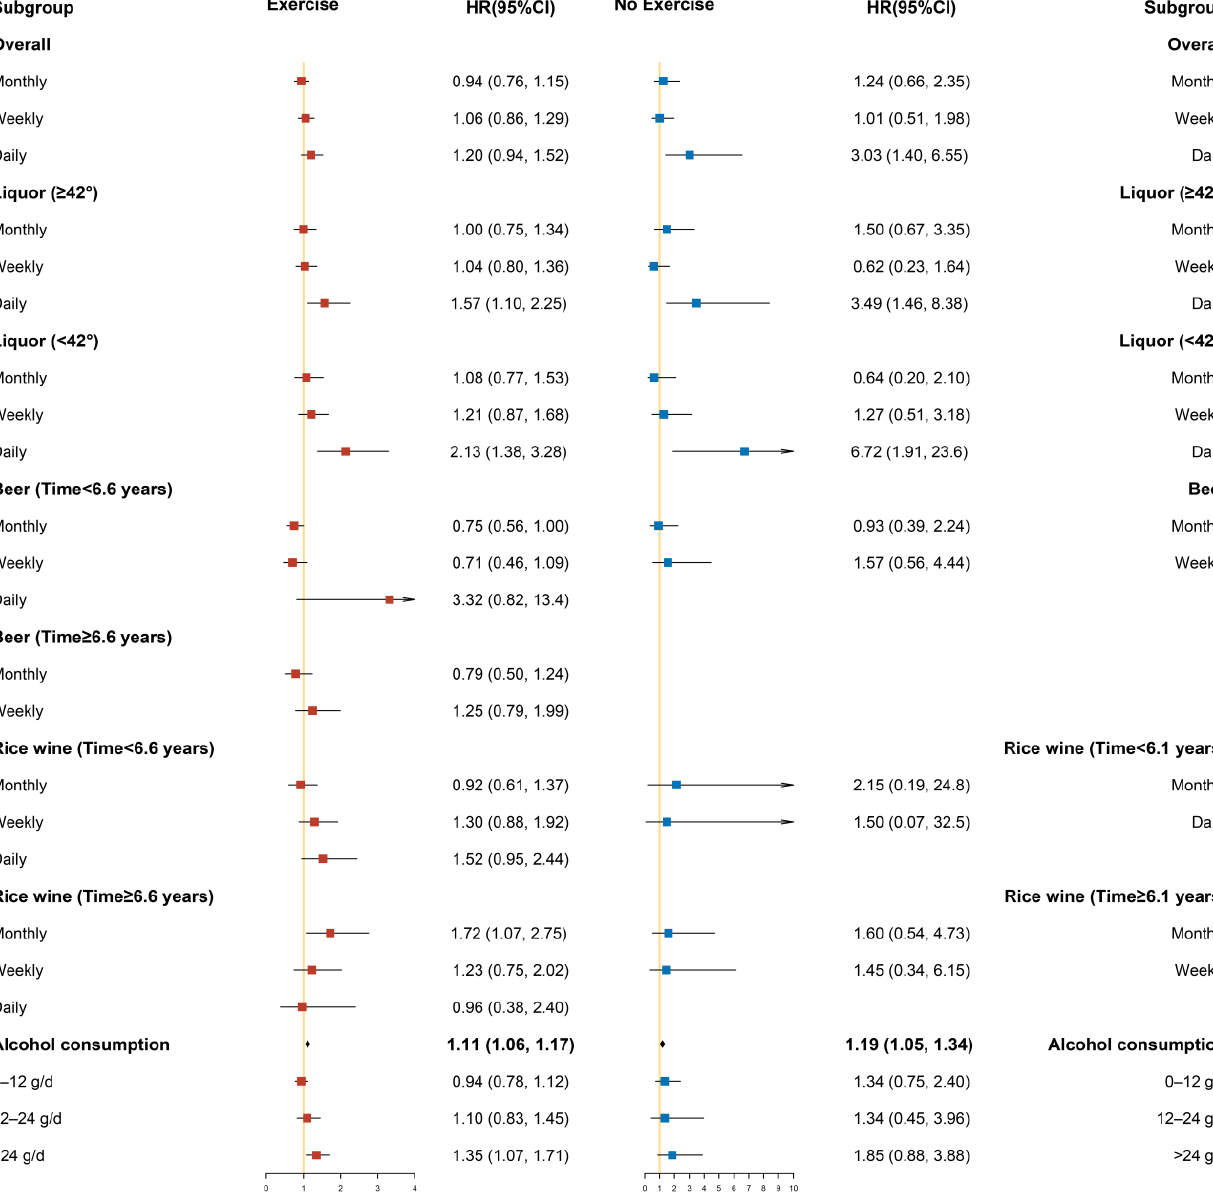
Figure 4. Subgroup analysis after stratification by exercise (Model 3).